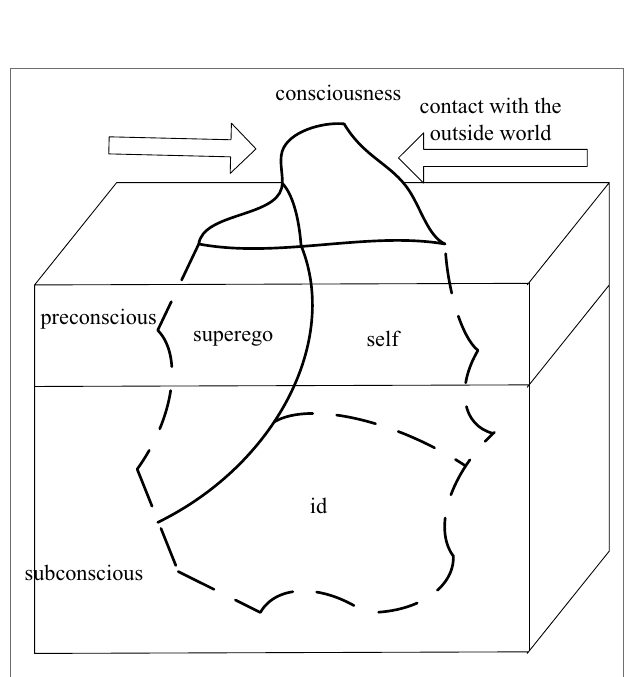
FIGURE 4 | Mental structure